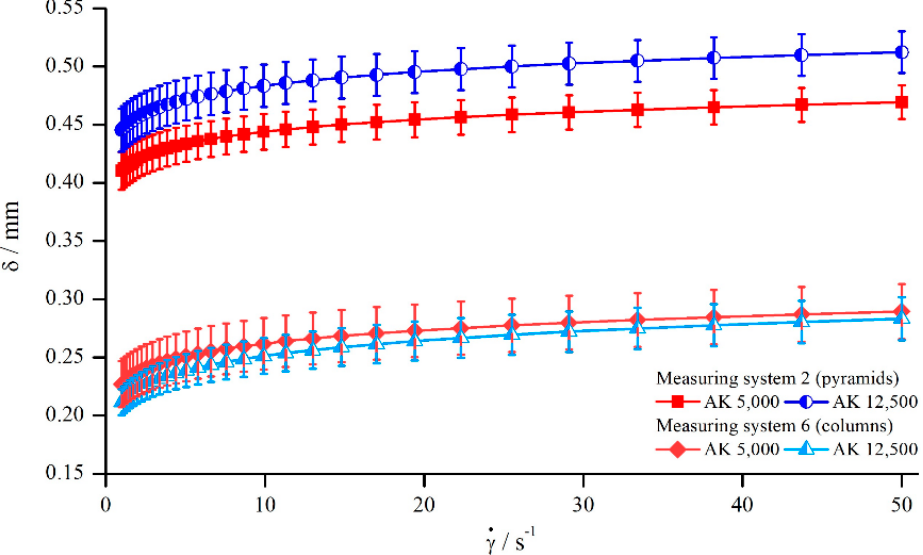
Figure 8. Correction function for the silicon oils AK 5000 and AK 12,500, measured with pyramids (systems 2) and columns (system 6).